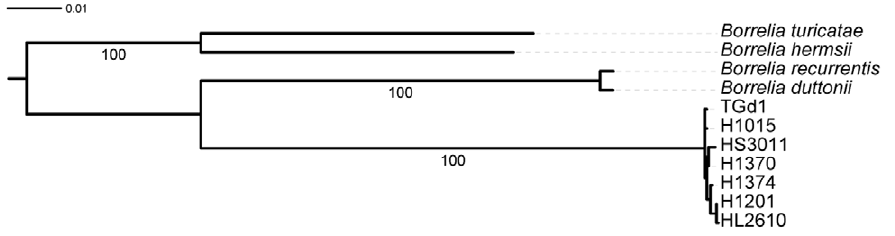
Figure 7. Phylogenetic tree based on the concatenated alignments of pur A, glp Q, fla B and rrs-ile T IGS nucleotide sequences. The tree was inferred using the PHYML program. The percentage of trees in which the associated taxa clustered together in the bootstrap test (100 replicates) is shown next to the branches if higher than 80%. The tree was arbitrarily rooted at midpoint.